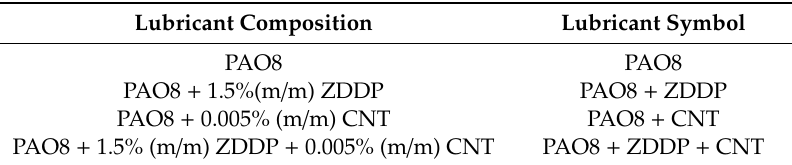
Table 3. Materials